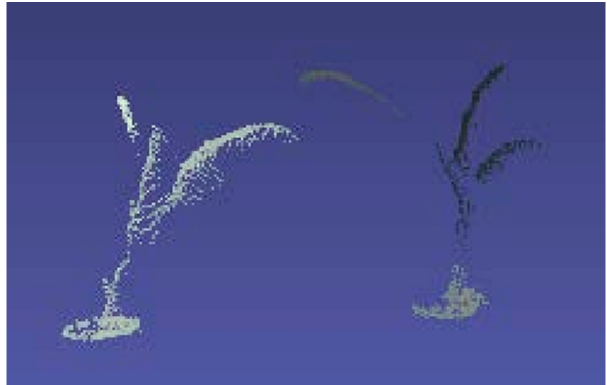
Figure 6. Result after ground removal with Random Sample Consensus (RANSAC) [64].